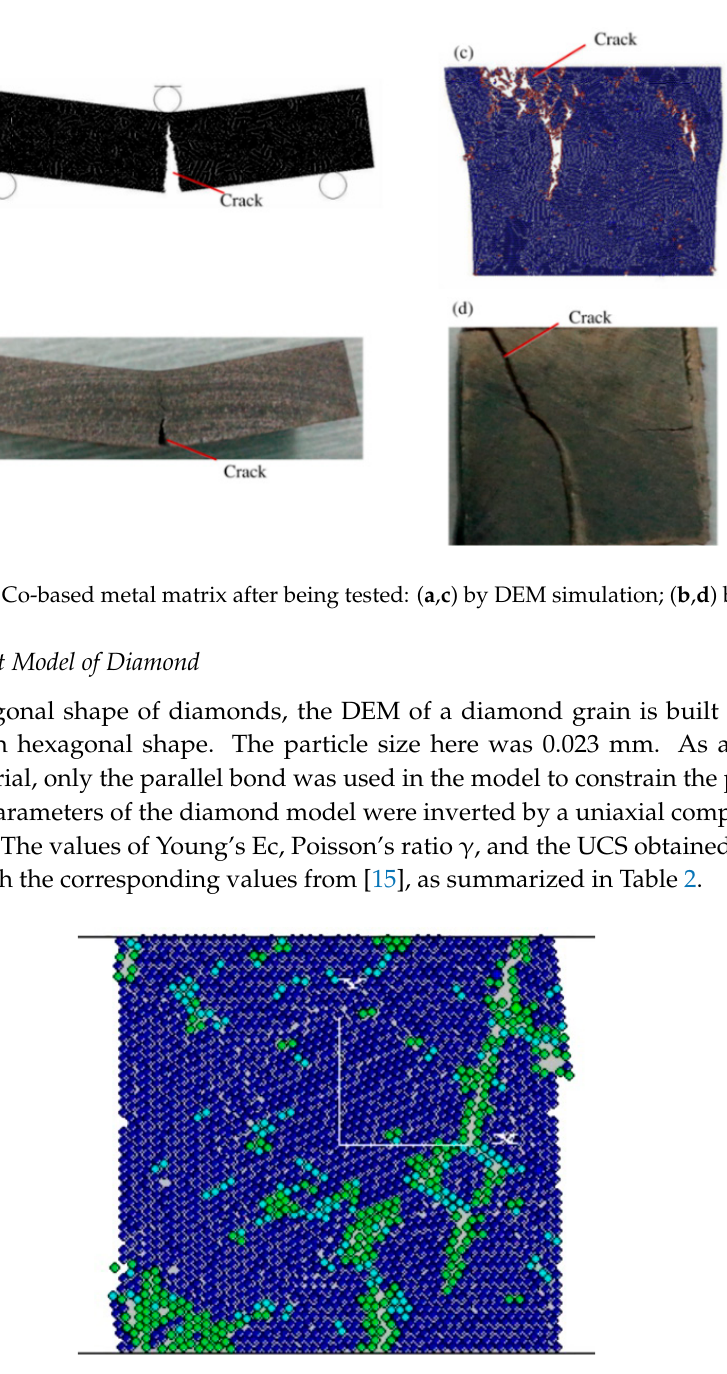
Figure 5. Compression test simulation of the diamond model. Table 2. Main mechanical properties of the diamond obtained by the DEM simulation and ref. [15].